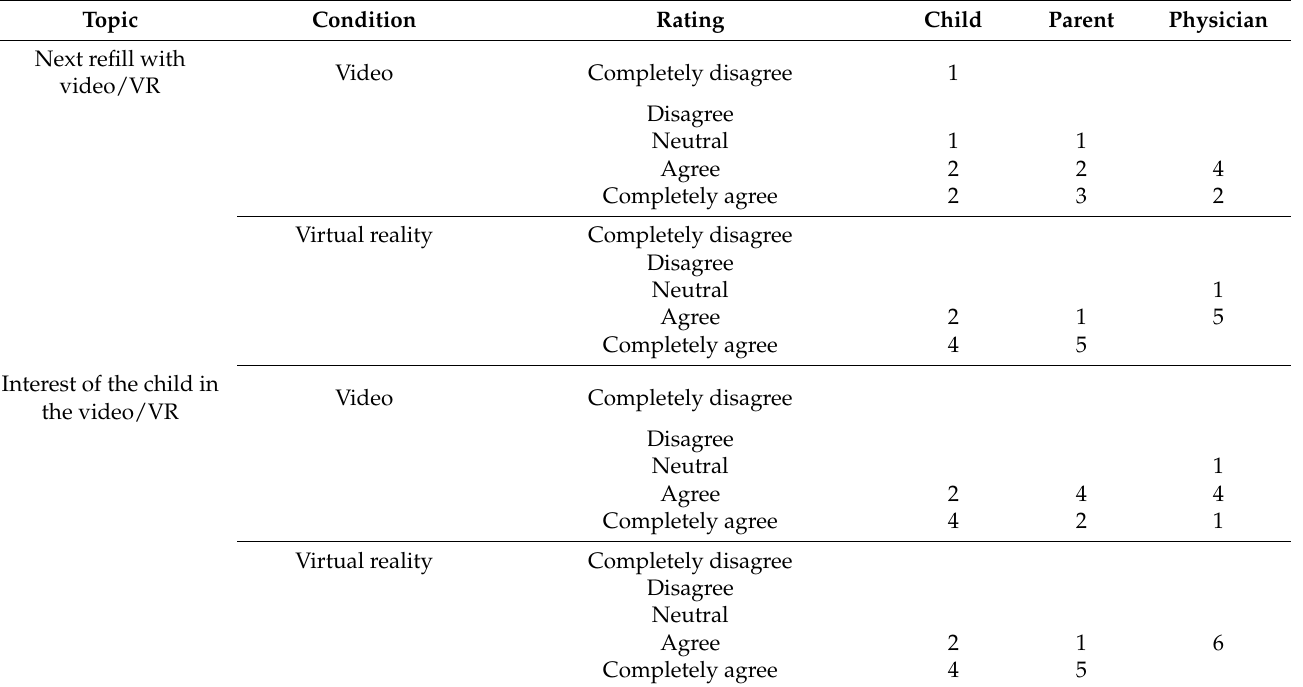
Table 2. Satisfaction with the refill procedures with video and virtual reality, according to children, parents and the